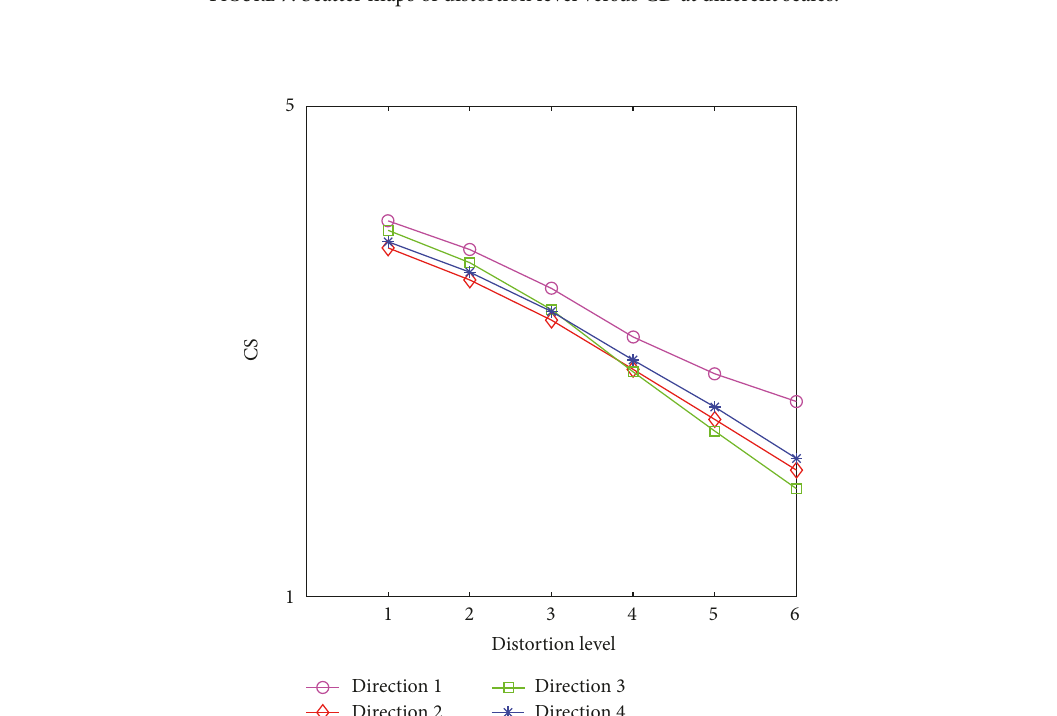
Figure 7: Scatter maps of distortion level versus CD at different scales.